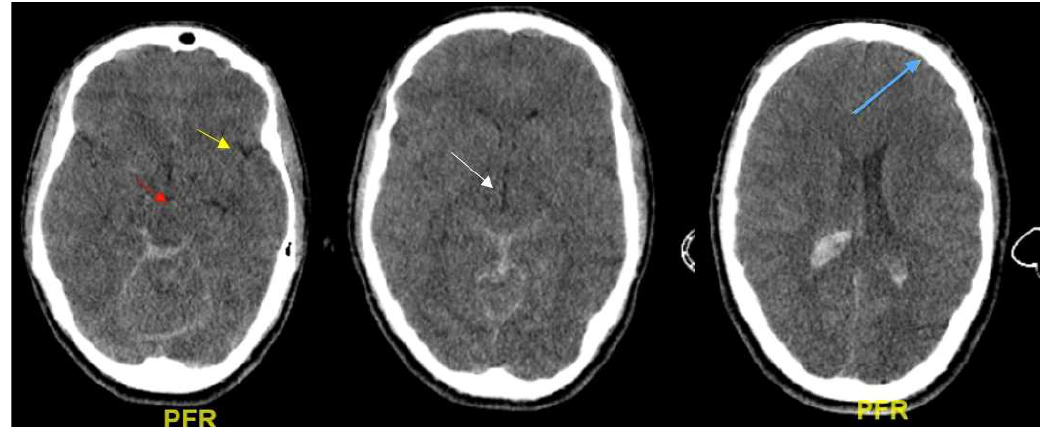
Figure 3. The axial CT scans evidence diffuse edema with subarachnoid and intracerebral hemorrhage: cortical sulci (blue arrow), and perimesencephalic cisterns (red arrow) are not visible, while Sylvian fissure (yellow arrow) and third ventricle (white arrow) are compressed but still visible.